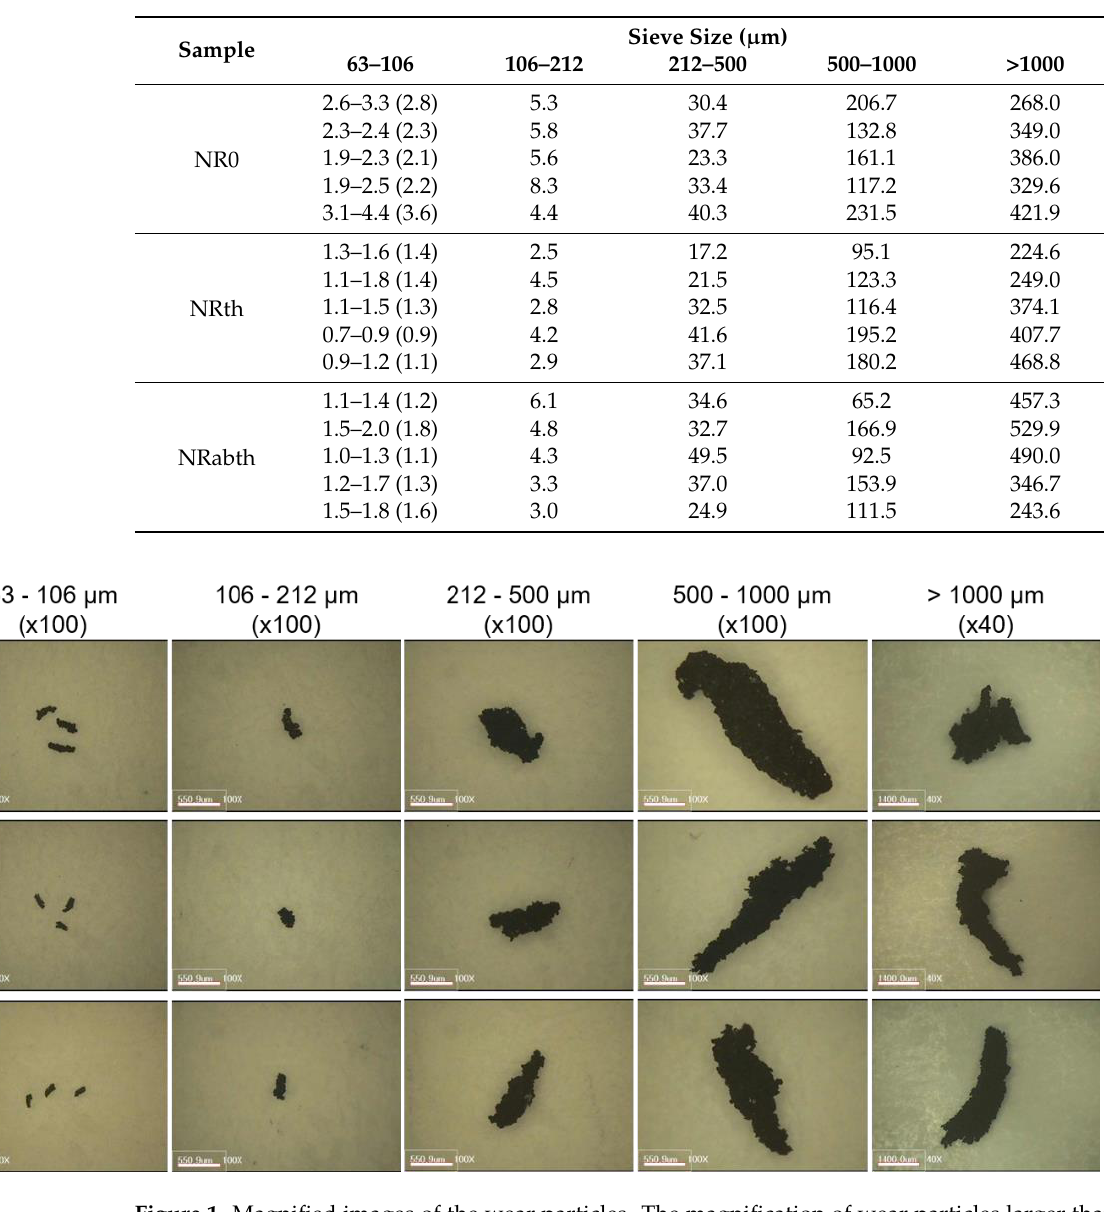
Table 2. Sizes of the wear particles used in this study (10 4 µ m 2 ). The wear particle size is the multiplication of the long and short axes. Values in the parentheses of wear particles of 63–106 µ m were average particle sizes.